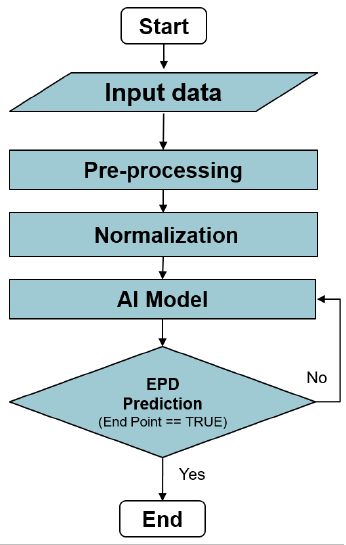
Figure 1. Flowchart of the training